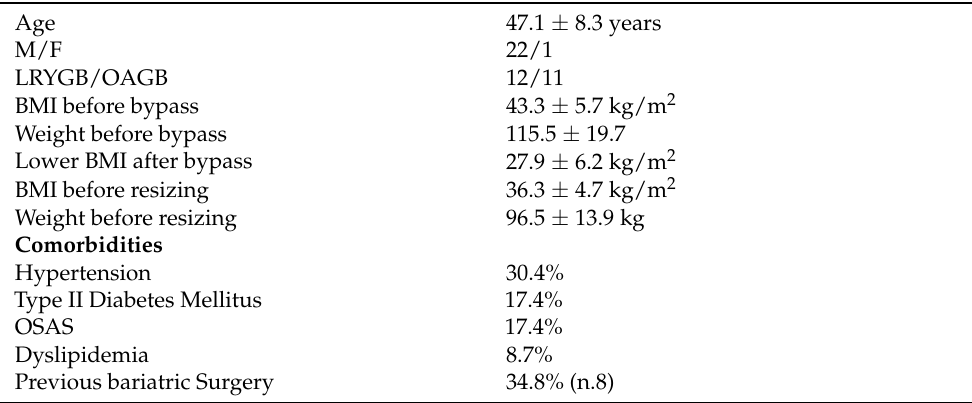
Table 1. Characteristics of the study population.